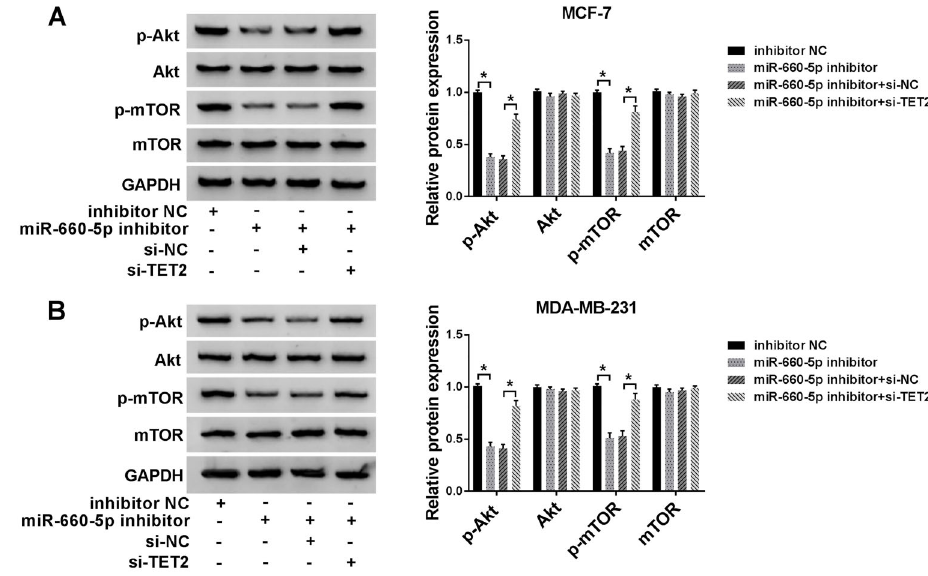
Figure 6. Phosphorylation of AKT, AKT, phosphorylation of mTOR, and mTOR were detected by western blot in MCF-7 ( A ) and MDA- MB-231 ( B ) cells transfected with inhibitor negative control (NC), miR-660-5p inhibitor, or miR-660-5p inhibitor plus si-NC or si-TET2 for 24 h (n=3). Data are reported as means ± SD. *P o 0.05